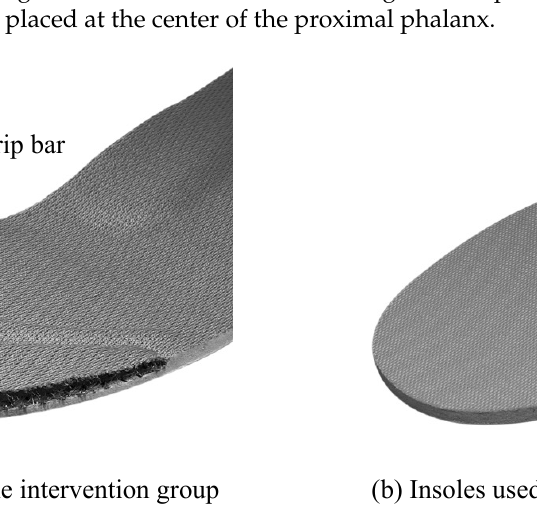
Figure 2. The insoles used in the intervention and control groups. ( a ) The intervention group used insoles consisting of a toe-grip bar and three-dimensional mesh. ( b ) The control group used regular insoles without a toe-grip